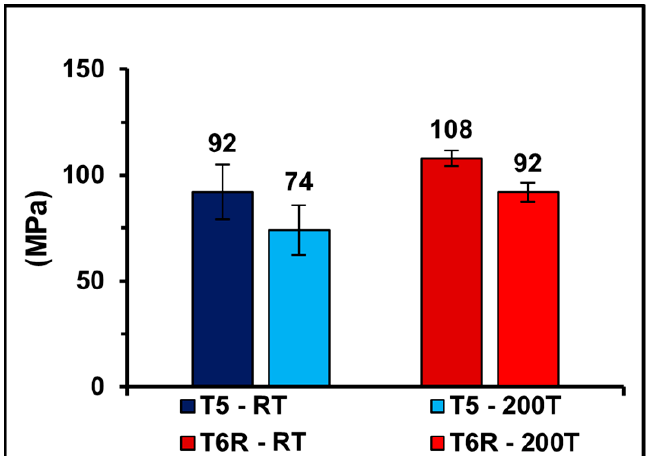
Figure 9. Fatigue strength ( σ fs,50% ) of the T5 and T6R alloys tested at room temperature (T5-RT and T6R-RT) (i) and high temperatures (T5-200T and T6R-200T) (ii). T-bars represent the standard deviation of fatigue strength.